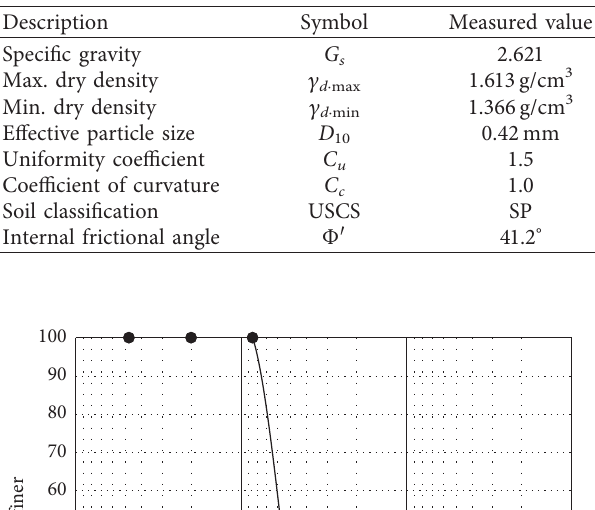
Table 1: Geotechnical engineering properties of Jumunjin standard sand.